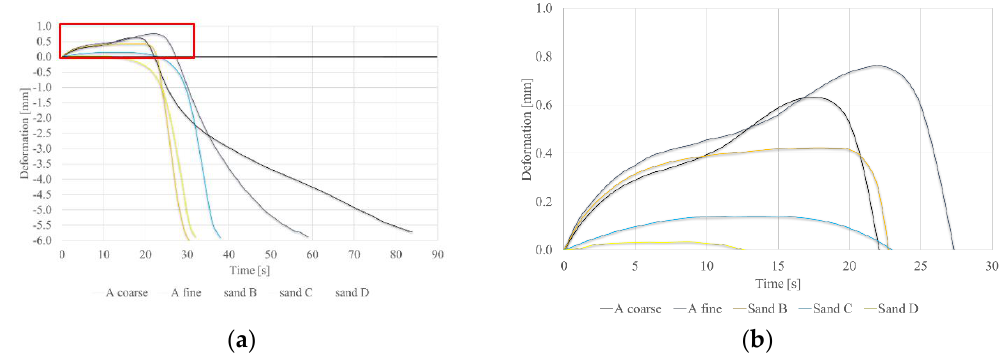
Figure 17. Hot-deformation curves of specimens made of tested sands: ( a ) general view, ( b ) detail.